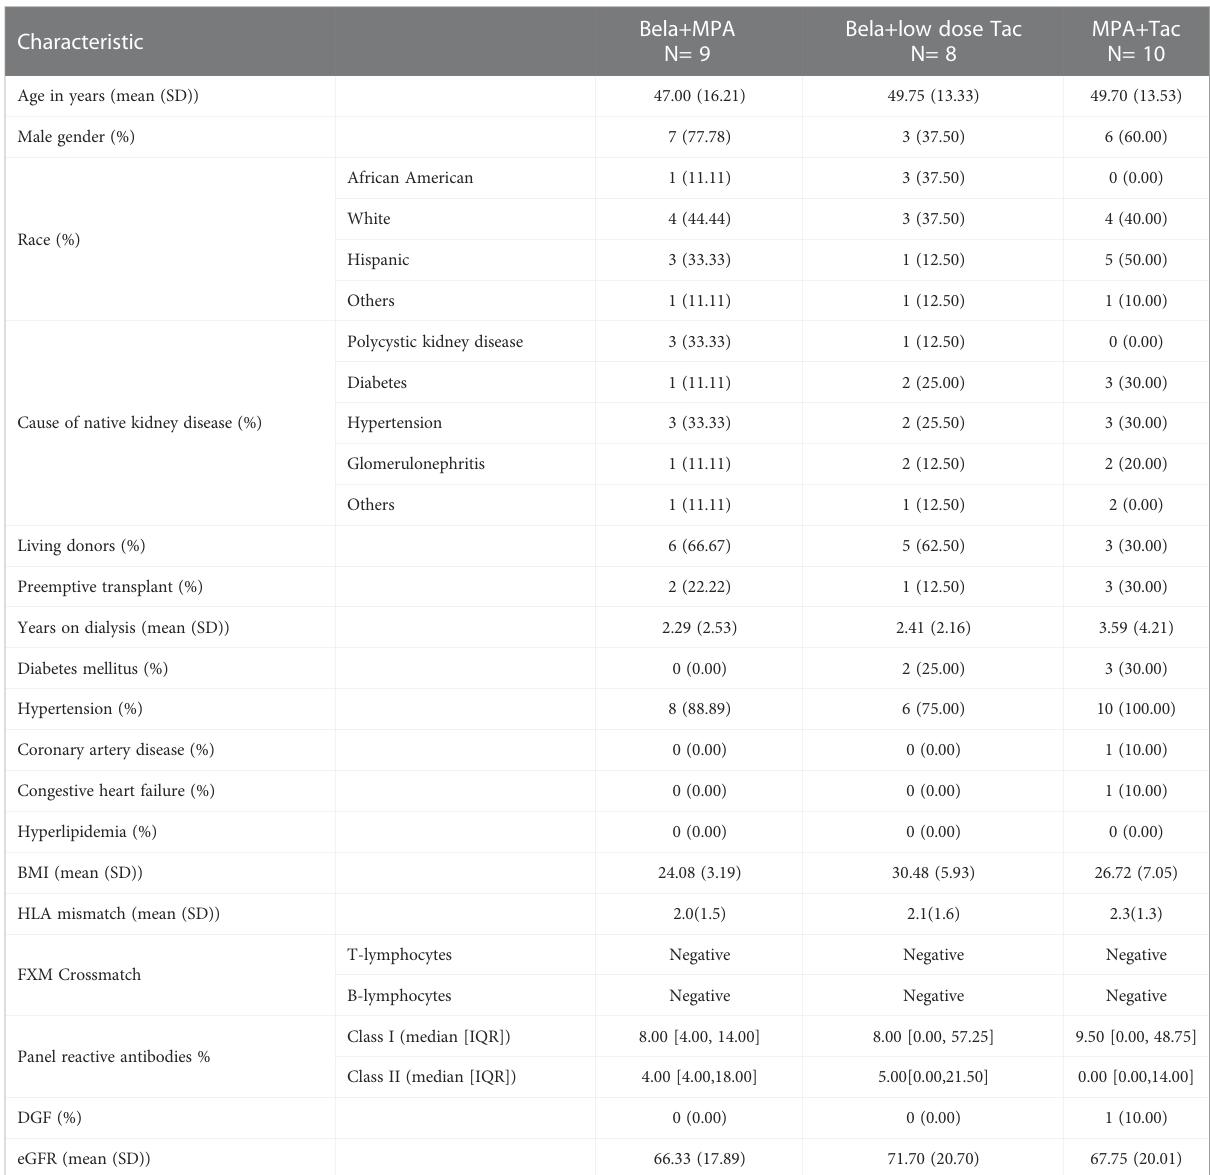
TABLE 1 Baseline